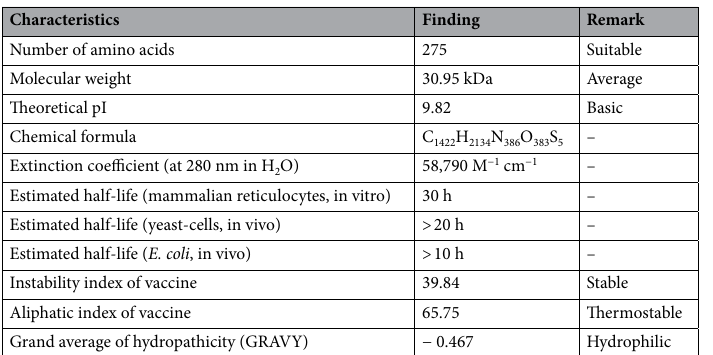
Table 5. The obtained physicochemical